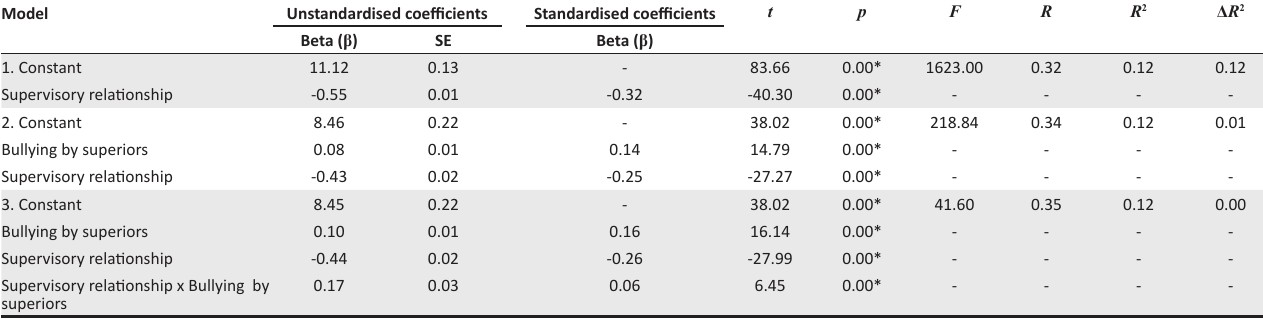
TABLE 6: Hierarchical regression analysis (supervisory relationship) with turnover intention as dependent variable. Model